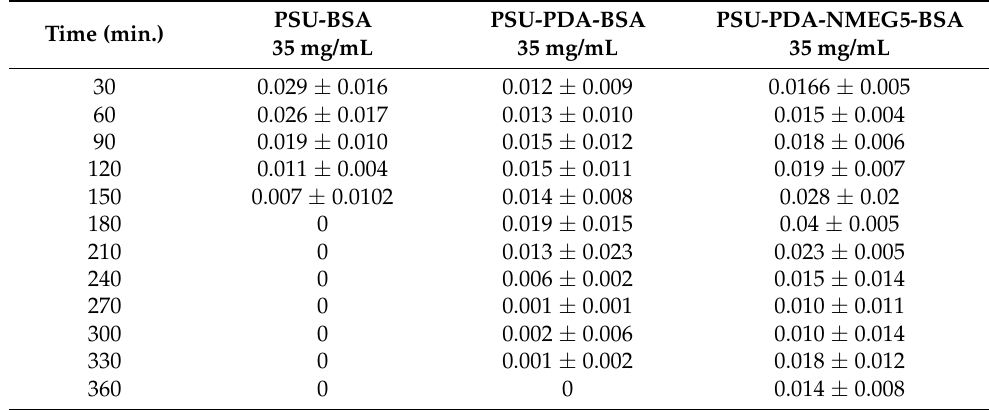
Table 1. Comparison of kLa (min − 1 ) between modified and unmodified fibers for 6 h. Time